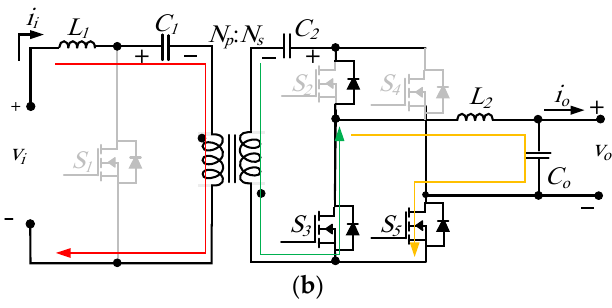
Figure 7. MCI as a DC/DC converter: ( a ) St dc 1 and ( b ) St dc 2 .